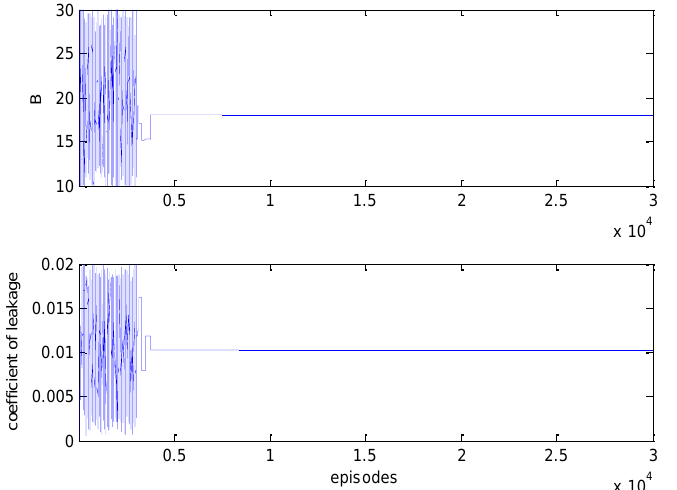
Figure 13. The episode training process of viscous damping coefficient and leakage coefficient subject to noise of uniform distribution.